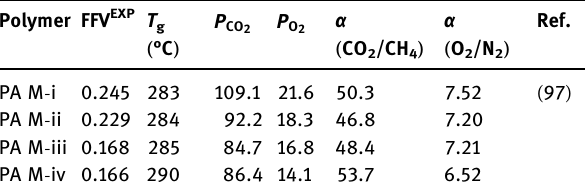
Table 11: FFV, T g , and gas permeability ( in Barrers ) and perm - selectivity values of the TB - based PAs measured at 3.5 bar pressure and 35°C